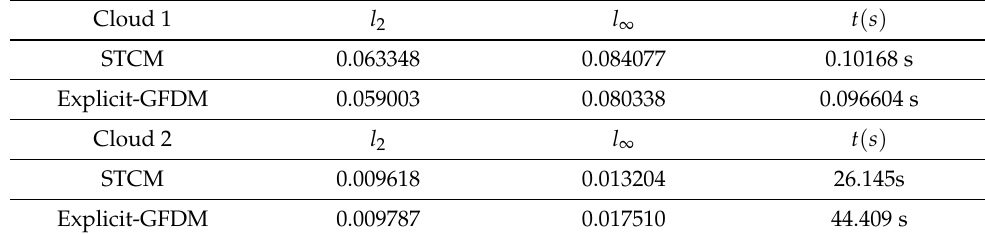
Table 2. Errors and execution time of the Example 2 in the clouds of Figures 3 and